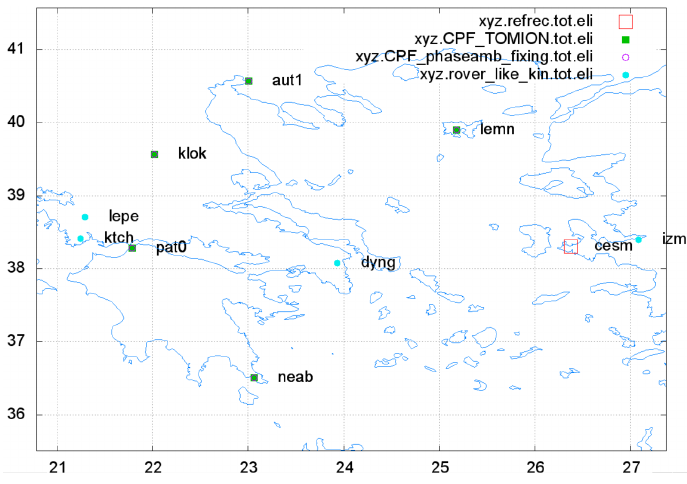
Figure 1. GNSS receivers from NOANET GNSS network in